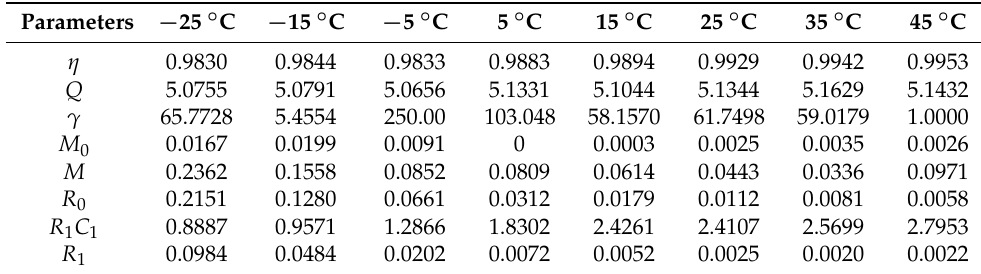
Figure 7. OCV versus SOC at various temperatures. Table 3. Results of identifying the cell model